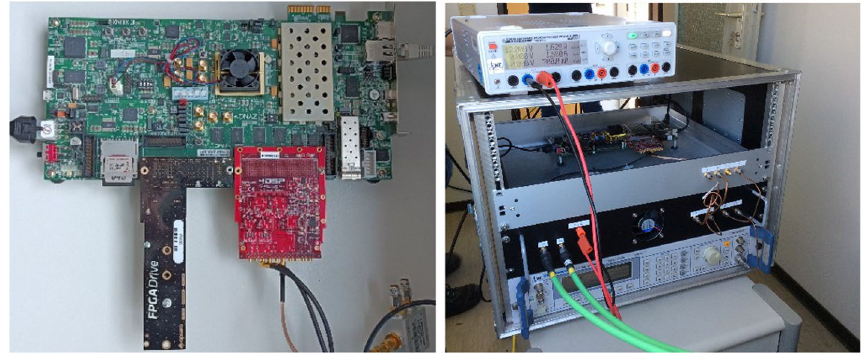
Fig. 22 Core elements of the digital back end (left) embodied in the upper tray of the demonstrator